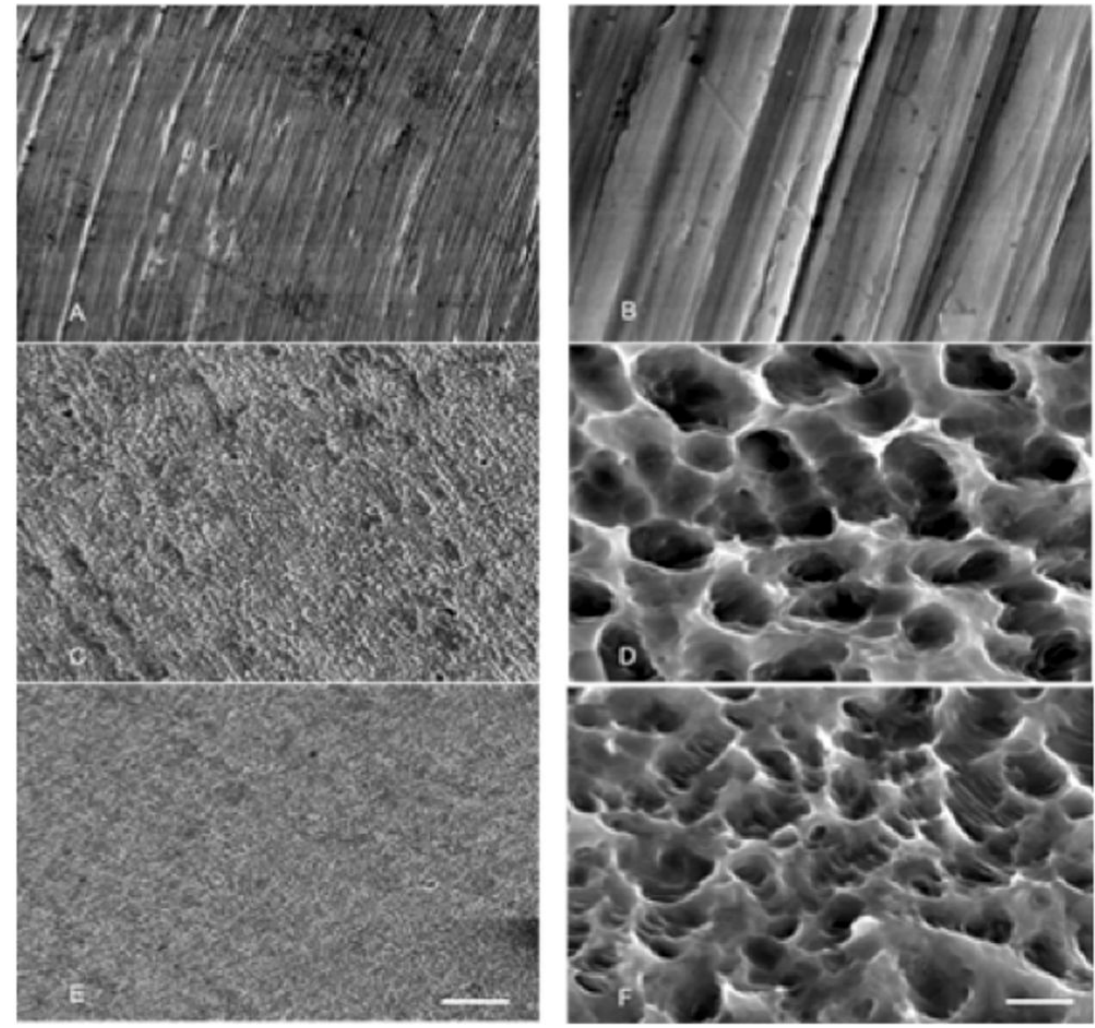
Figure 1. Scanning electron microscope micrographs of M (A, B), DE (C, D) and Nano F - surfaces (E, F). Scale bar = 100 μm (A, C, E) and 5 μm (B, D, F). M = machined, DE = double acid-etched, Nano F - = DE with deposition of fluoride